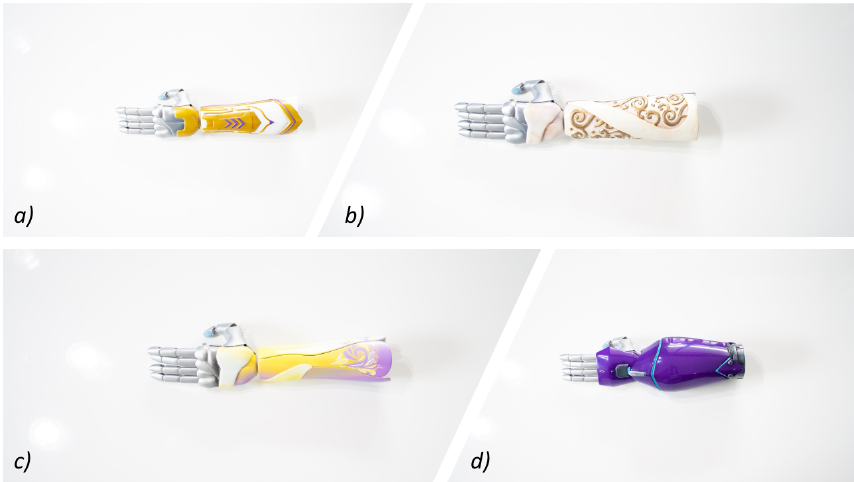
Figure 6. 3D-printed electromyographic actuated limb device with interchangeable artistic covers from Limbitless Solutions at the University of Central Florida. ( a ) Warrior class, ( b ) Ethereal class, ( c ) Serenity class, and ( d ) Shadow